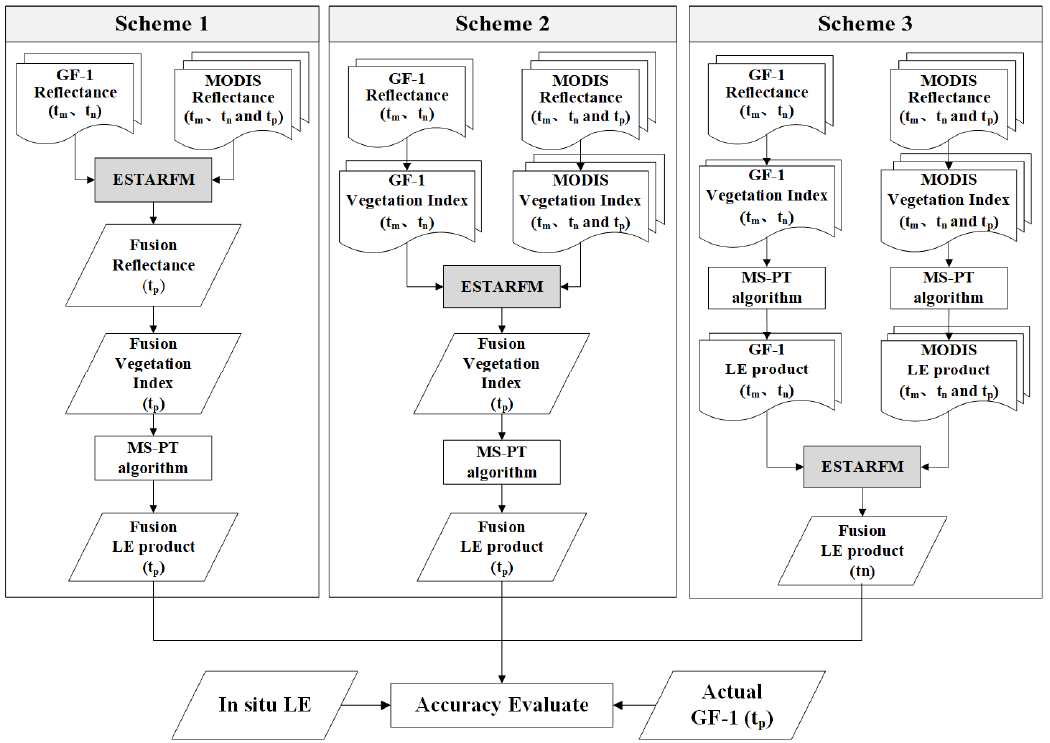
Figure 2. Flowchart of the proposed three fusion schemes using GF-1 and MODIS data.